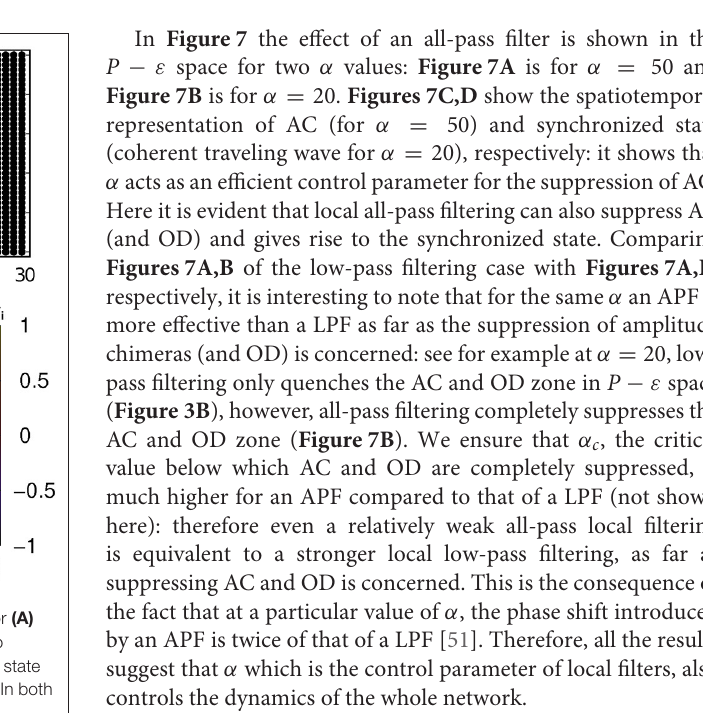
FIGURE 7 | With all-pass filtering: Phase diagram in the P α 50 and (B) α 20. (C) spatiotemporal plot of AC corresponding to = = α 50 (shown by H in A ). (D) spatiotemporal plot of the synchronized state = (coherent traveling wave) corresponding to α (C,D) ε 12, P 15, ω = = =